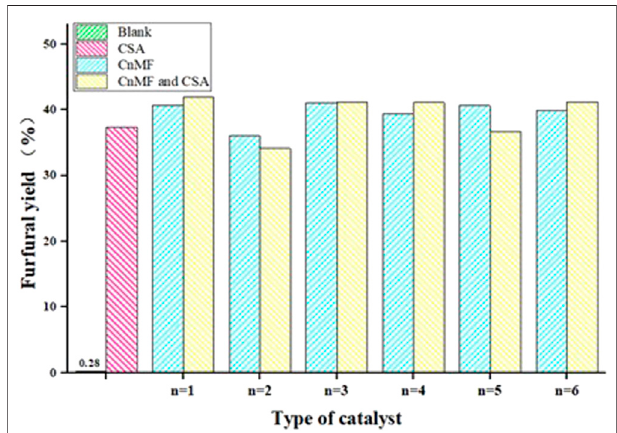
FIGURE 4 | The effect of catalyst type on reaction. Reaction conditions: xylose (60 g/L), 0.1 g CSA, 1 g C n MF, 200 ° C, 10